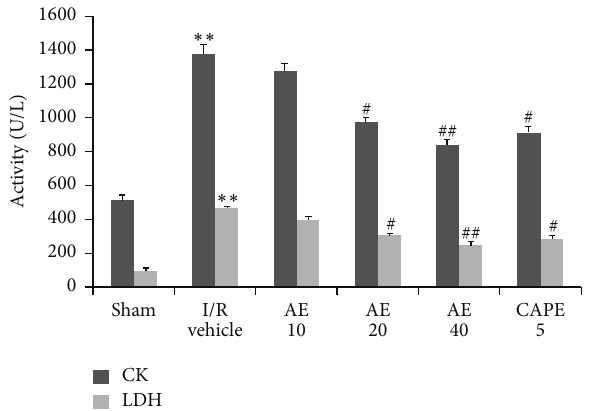
Figure 4: Effects of AE on CK and LDH activities in serum after myocardial I/R in rats. Hearts were subjected to 30 min ischemia followed by 24 hours’ reperfusion. Different doses of AE (10, 20, or 40 mg/kg), CAPE 5 mg/kg, or saline (1mL/kg) were administered via the tail vein 1min before reperfusion. 𝑛 = 5 /group. ∗∗ 𝑃 < 0.01 , versus Sham; # 𝑃 < 0.05 , ## 𝑃 < 0.01 versus I/R